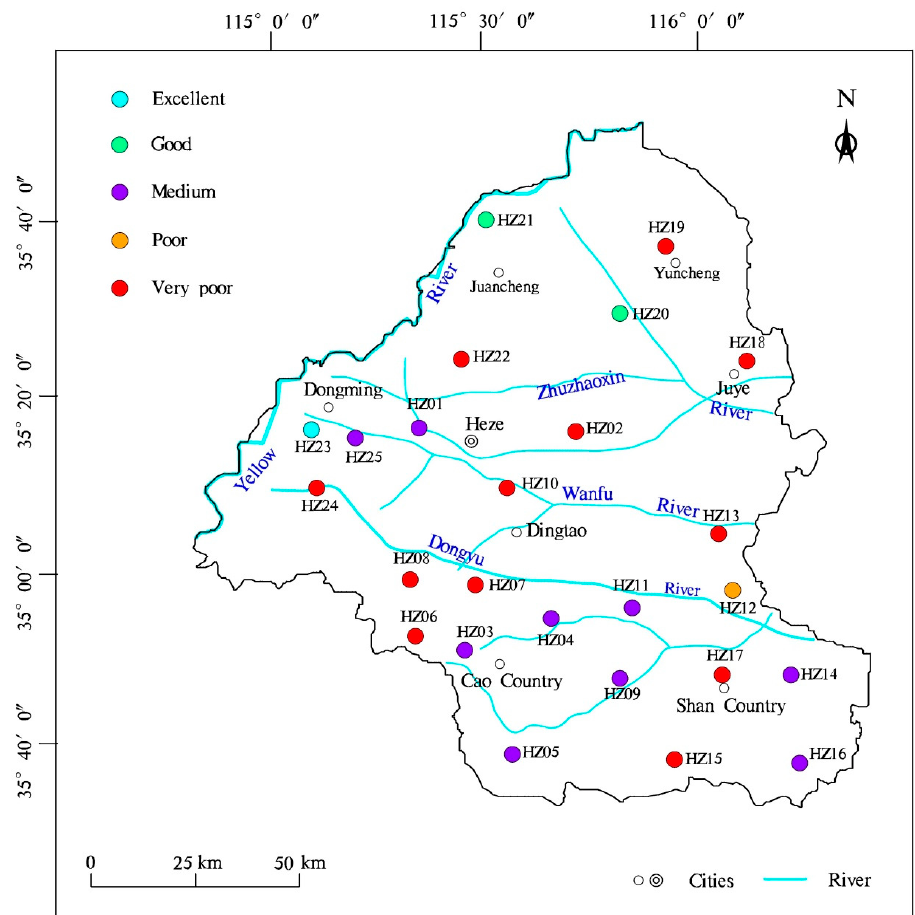
Figure 10. Results of groundwater quality for drinking uses in 2017.